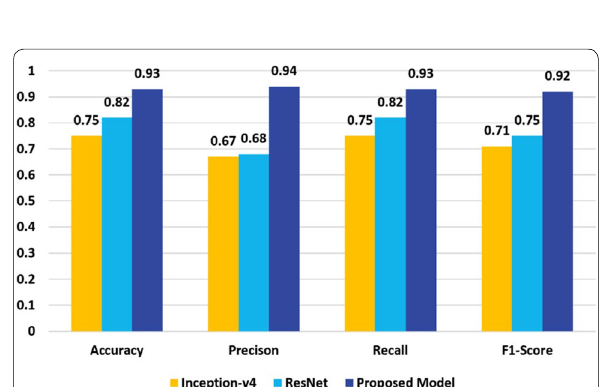
Fig. 9 Performance comparison of the proposed model and the baseline deep CNNs